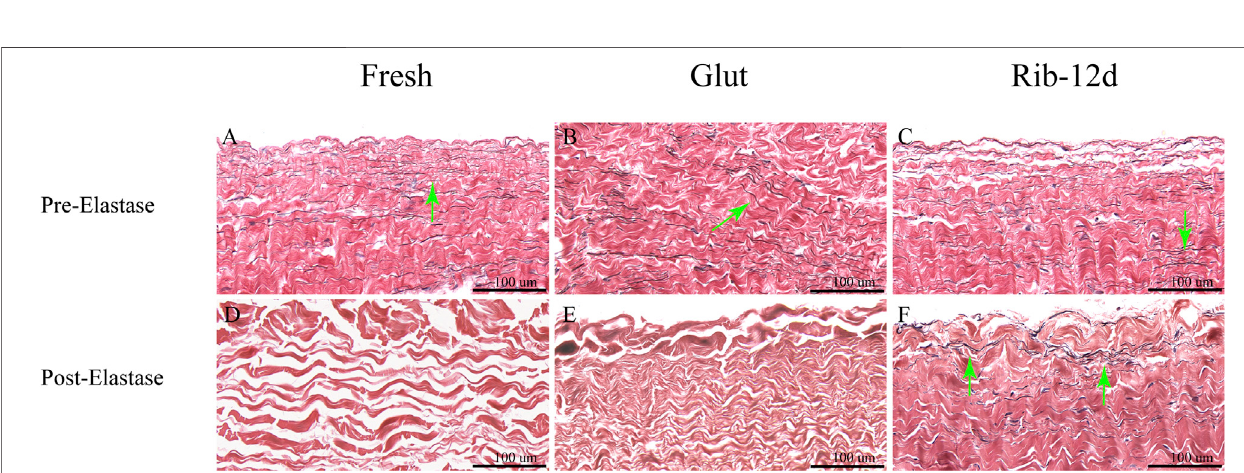
Frontiers in Bioengineering and Biotechnology |